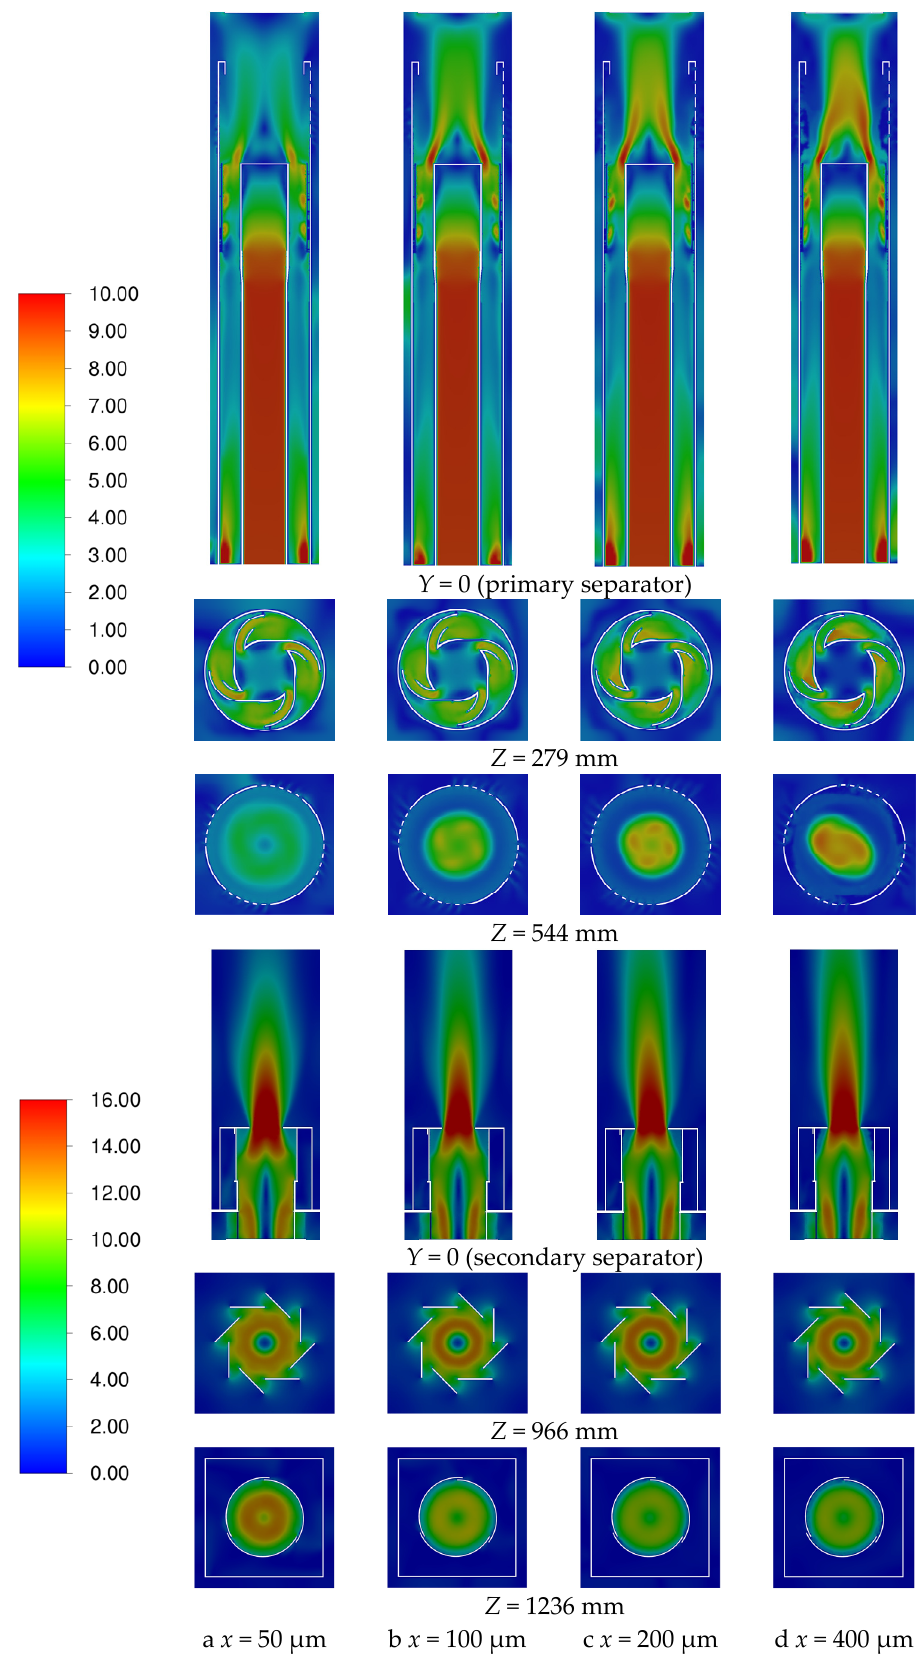
Figure 7. Distribution of Steam Velocity (unit: m/s).